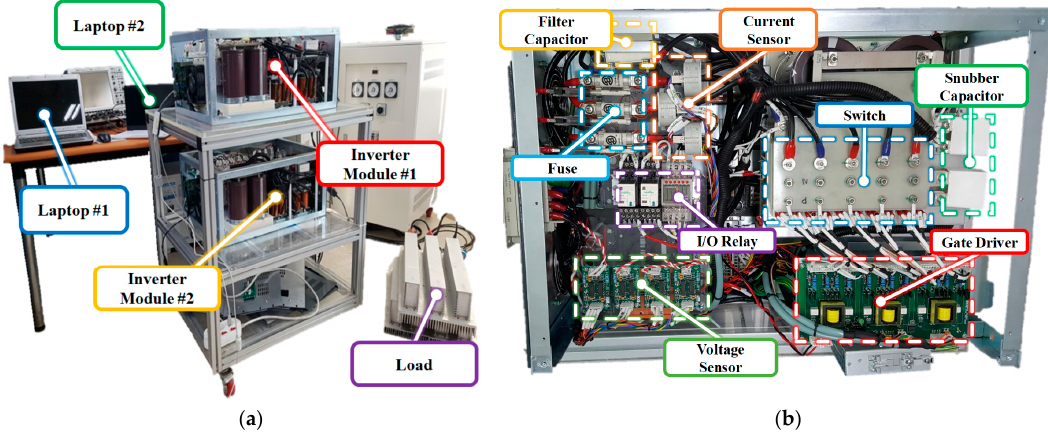
Figure 11. ( a ) Experimental setup consisting of two parallel-inverters; ( b ) each power stack.